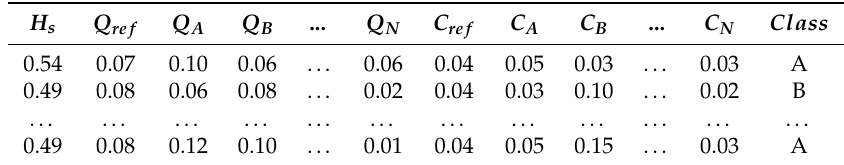
Table 2. Table of values obtained by calculating the entropy, divergence and complexity for a problem with